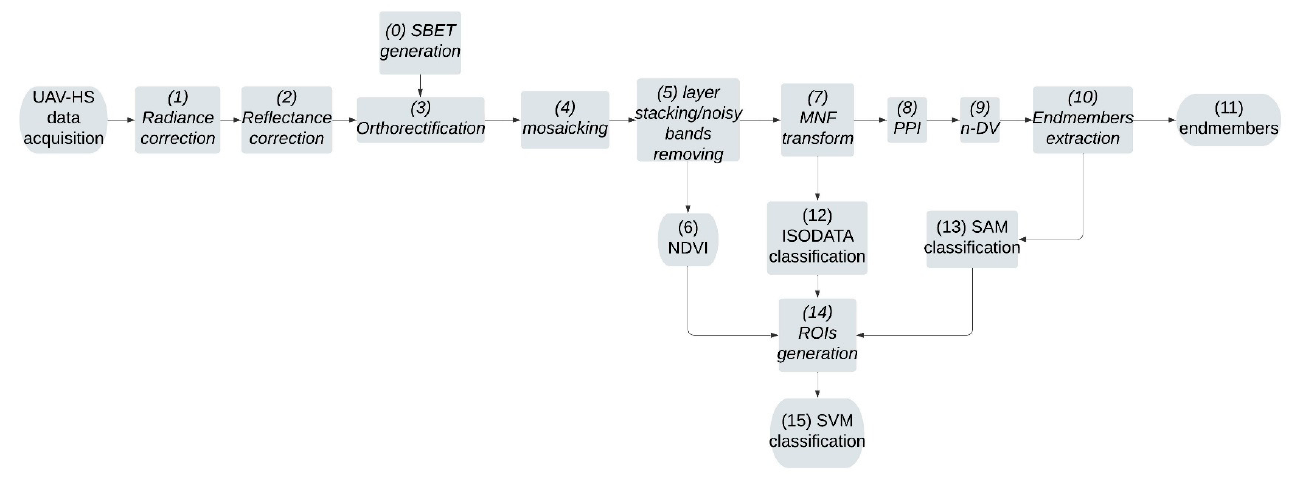
Figure 3. Flowchart showing the hyperspectral processing steps. Rounded boxes indicate data or products, rectangle boxes represent processes. Numbers in brackets refer to the respective explanation in the text. SBET: smoothed best estimate of trajectory; MNF: minimum noise fraction; PPI: pixel purity index; n-DV: n-dimensional visualizer; NDVI: normalized difference vegetation index; SAM: spectral angle mapper; ROIs: regions of interest; SVM: support vector machine. See text for details.